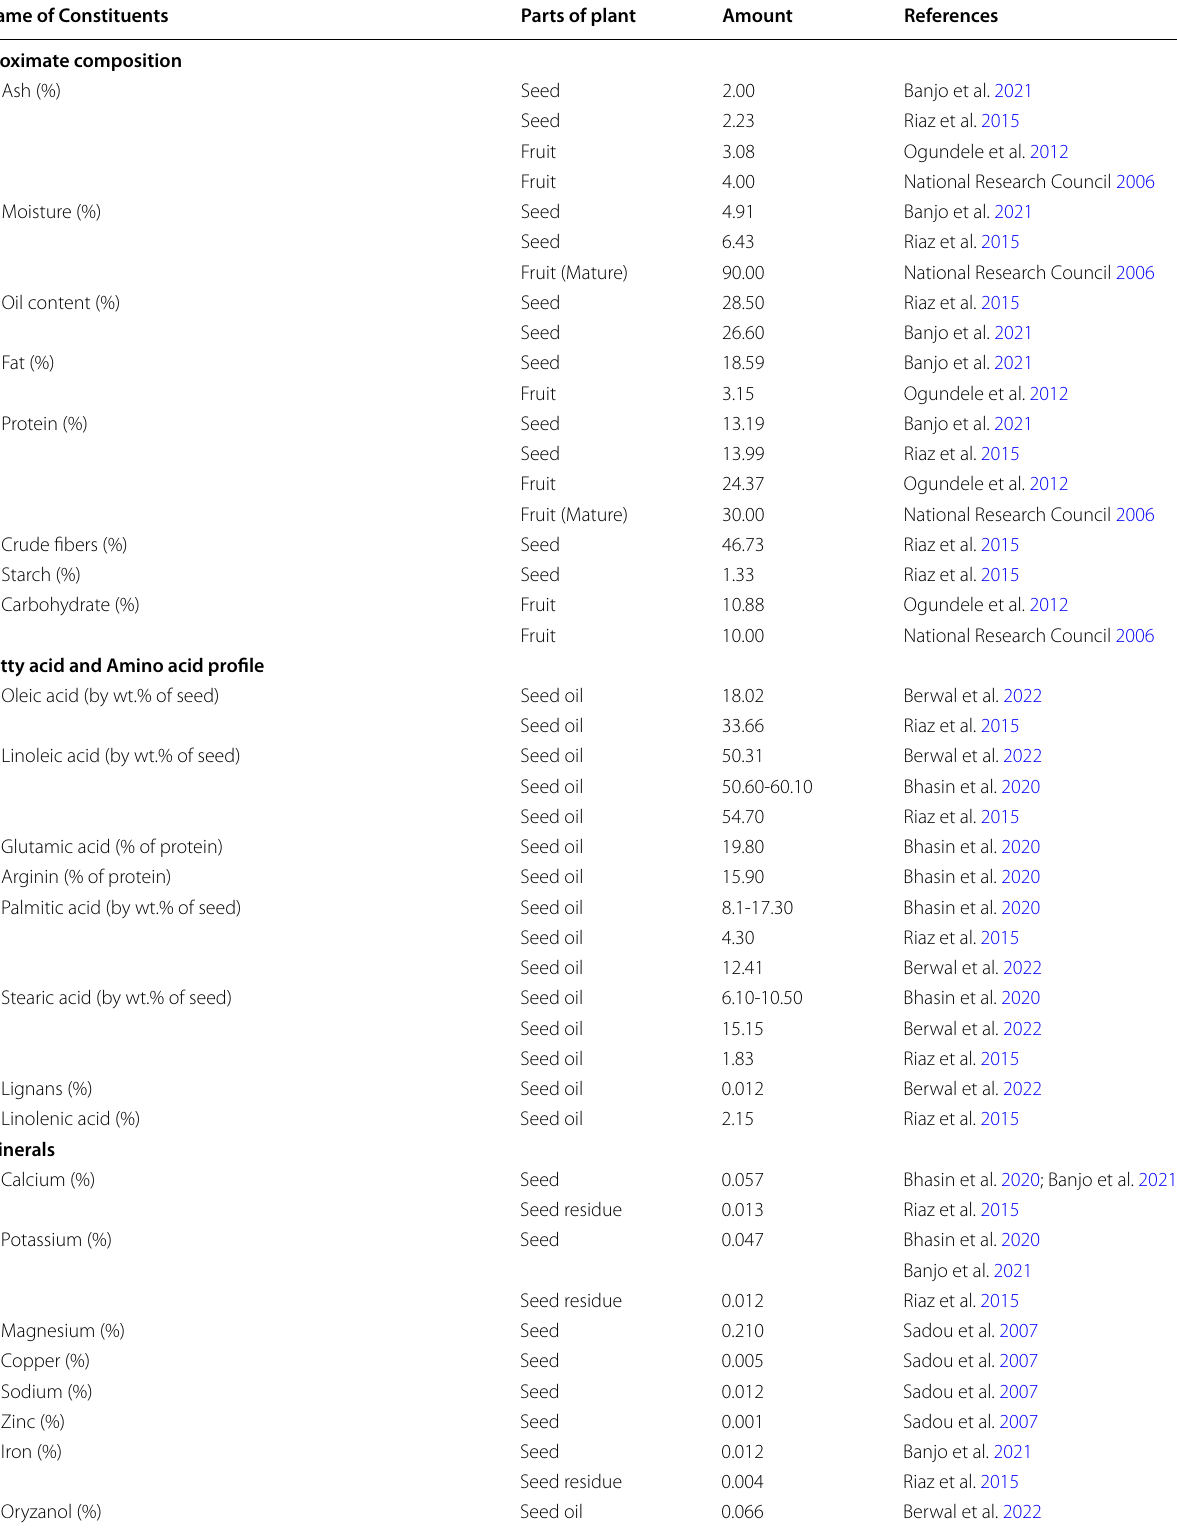
Table 1 Nutritional and fatty acid composition of different parts of bitter